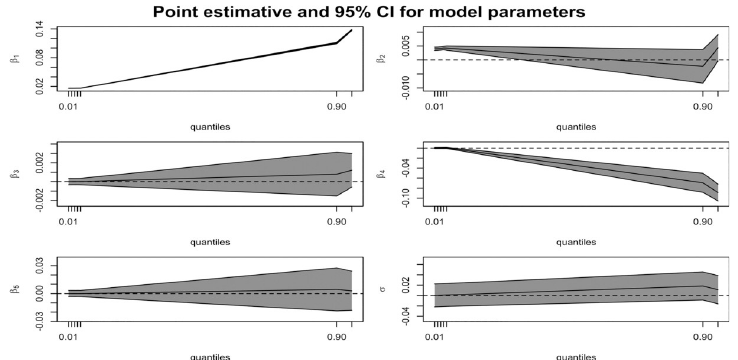
Fig 2. Estimated 95% CI for model parameters of extra points. Here, Intercept as ( β 1 ), Postseason as ( β 2 ), Away as ( β 3 ), Icing as ( β 4 ), and pressure as ( β 5 ).